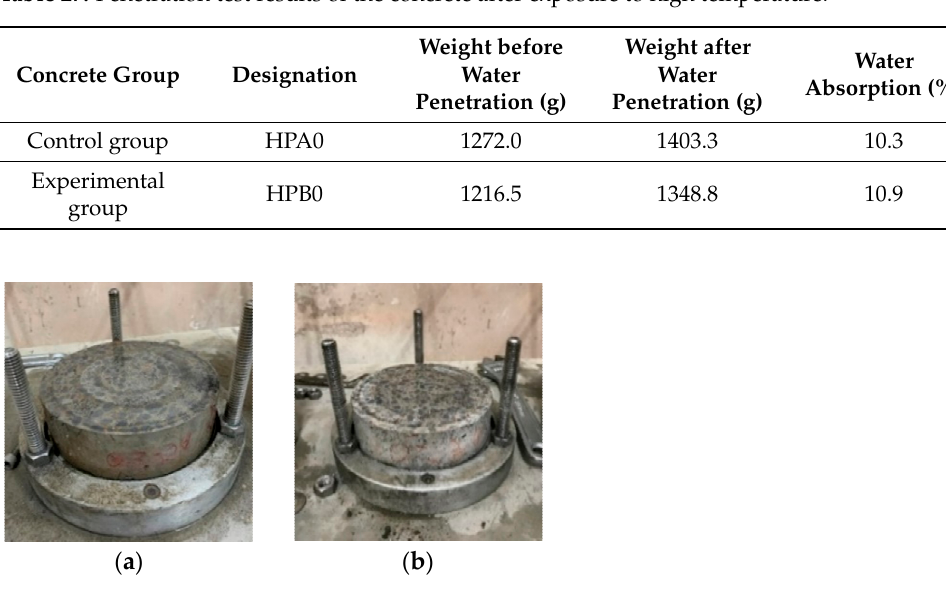
Table 27. Penetration test results of the concrete after exposure to high temperature.